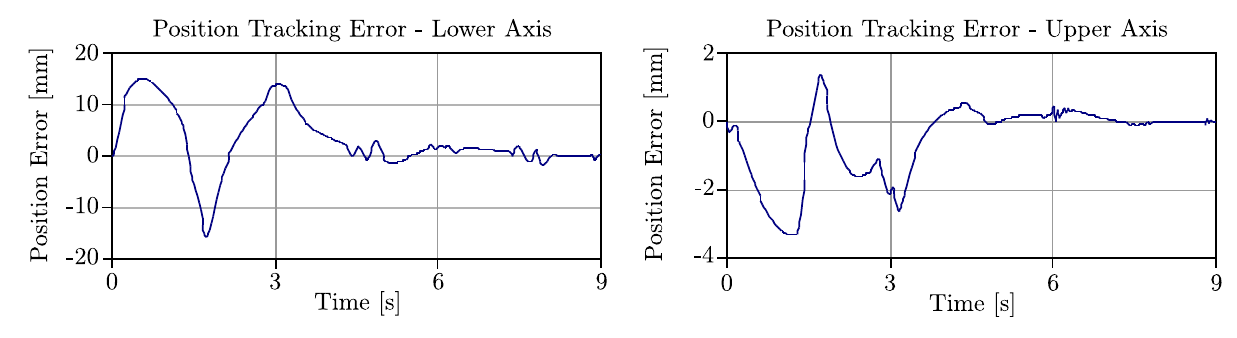
Figure 7: Tracking error - upper axis